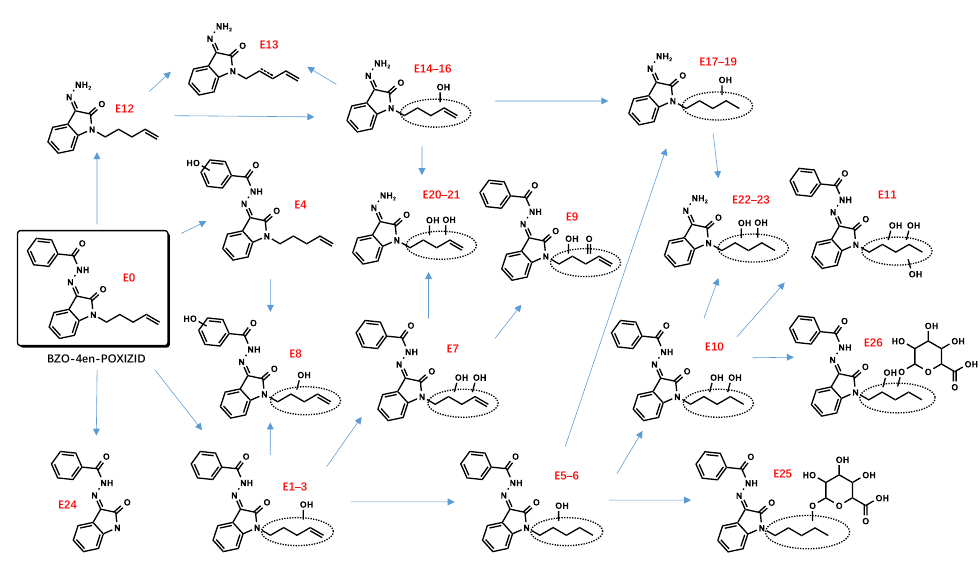
Figure 7. Proposed metabolic pathway of BZO-4en-POXIZID.